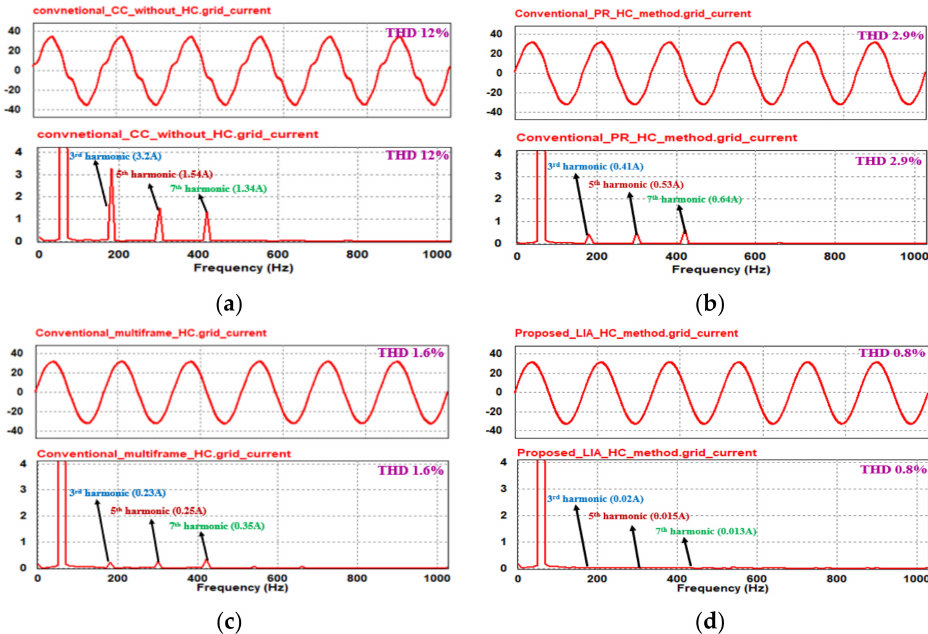
Figure 9. Simulation results of harmonic compensation methods at 5 kW ( a ) without harmonic compensation, ( b ) conven- tional PR-based harmonic compensation, ( c ) conventional individual multiple frame harmonic compensation, ( d ) proposed LIA harmonic compensation.